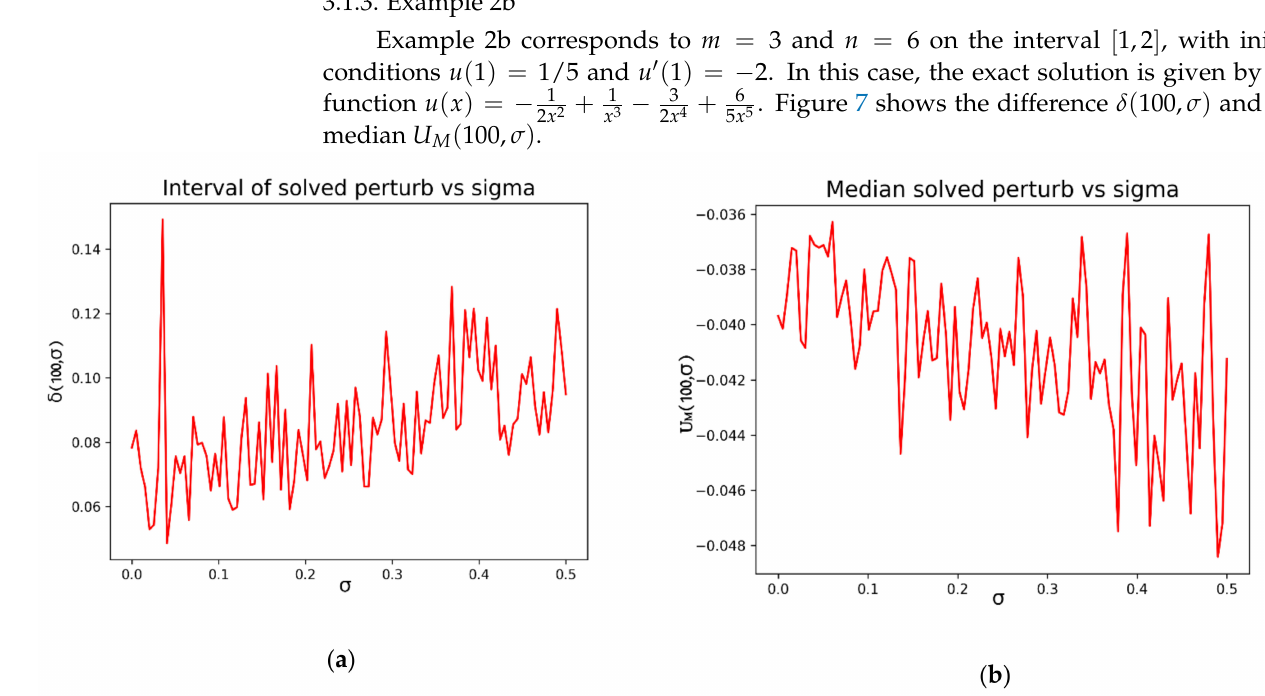
Figure 7. Effect on the solution of different standard deviation for 200 samples of the normal perturbation term: ( a ) Range of the differences δ ( 100, σ ) ; ( b ) Median of the difference between the numerical solutions and the exact solutions at right extreme of the interval U M ( 100, σ ) .